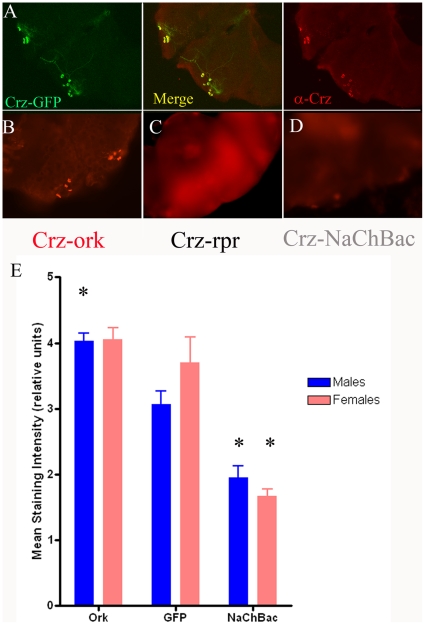
Manipulations of corazonin neurons alter levels of corazonin immunoreactivity.(A) Representative image of an adult brain stained with anti-corazonin expressing a GFP transgene in corazonin cells showing co-localization of immunosignals and GFP expression. (B) Representative image of an adult brain expressing the ork transgene. (C) Lack of corazonin immunosignals in brains expressing the reaper construct which induces apoptosis. For this image, we increased the brightness of the background to show that no cell bodies were stained with the corazonin antibody. (D) Representative brain from fly expressing the NaChBac transgene in corazonin neurons, which is aimed to facilitate peptide secretion, and note less intense staining in the soma of corazonin expressing neurons. (E). Quantification of immunosignals in each of these different treatments was performed on ten brains per genotype per sex. Images were collected under the same microscope settings. For quantification, a region of interest was drawn to include corazonin neuronal cell bodies and divided by the pixel intensity of a similar sized area of the brain lacking corazonin immunosignals. For animals expressing the reaper construct, there was no evidence of any corazonin immunolabels, preventing this analysis. Asterisks indicate significant differences (p<0.05) between the Crz-GFP ratios as determined by ANOVA.